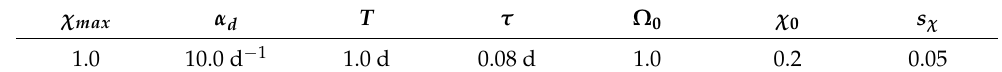
Table 4. Choice of kinematic and dynamical parameters of the drug model.